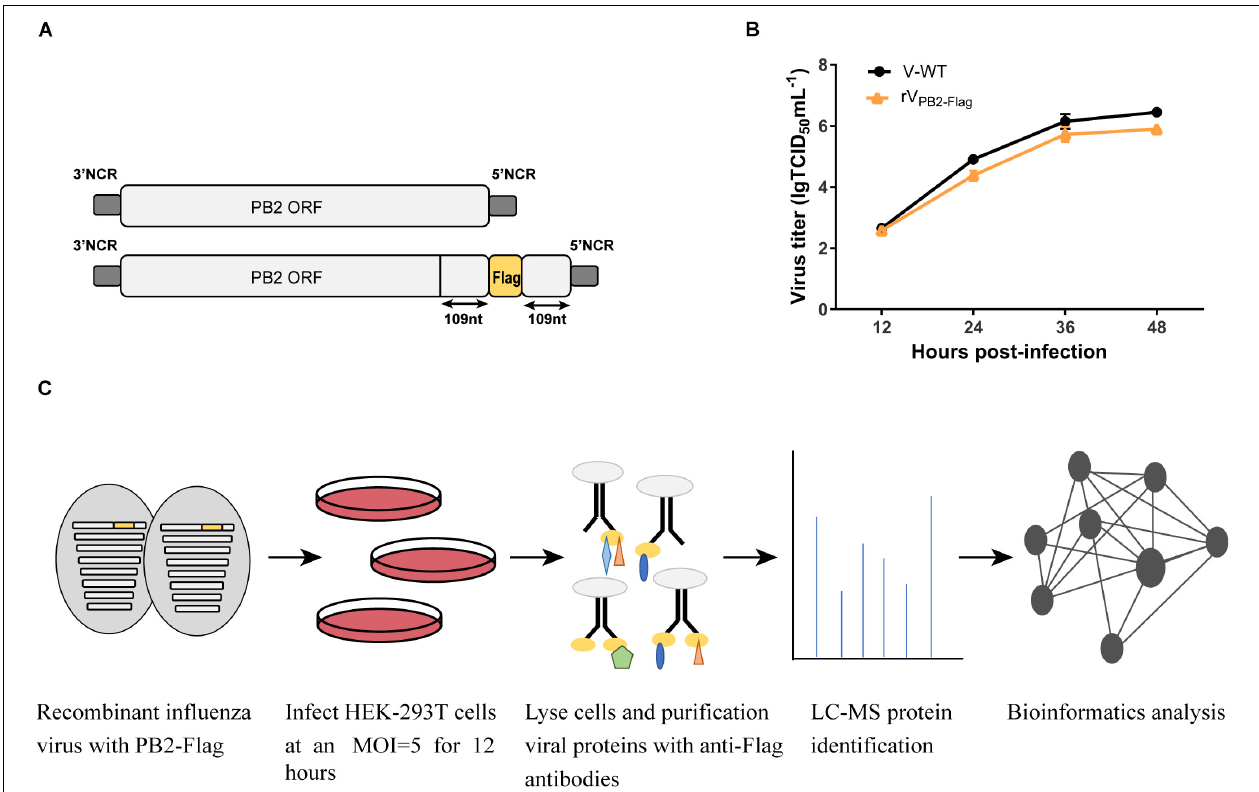
FIGURE 1 | Schematic overview of the strategy to identify host factors associated with PB2 during virus infection. (A) Generation of the recombinant influenza virus showing the PB2 segment C-terminal fused with Flag tag. (B) Growth kinetics of WT virus (V) and PB2-Flag virus (rV PB2 − Flag ) in MDCK cells infected at an MOI of 0.001. (C) Schematic diagram of the systematic analysis of host proteins interacting with PB2 during virus infection. HEK-293T cells were infected with recombinant influenza virus rV PB2 − Flag at an MOI of 5. At 12 hpi, infected cells were harvested and subjected to a pulldown assay with anti-Flag affinity gel. Purified protein samples were subjected to LC-MS protein identification followed by bioinformatics